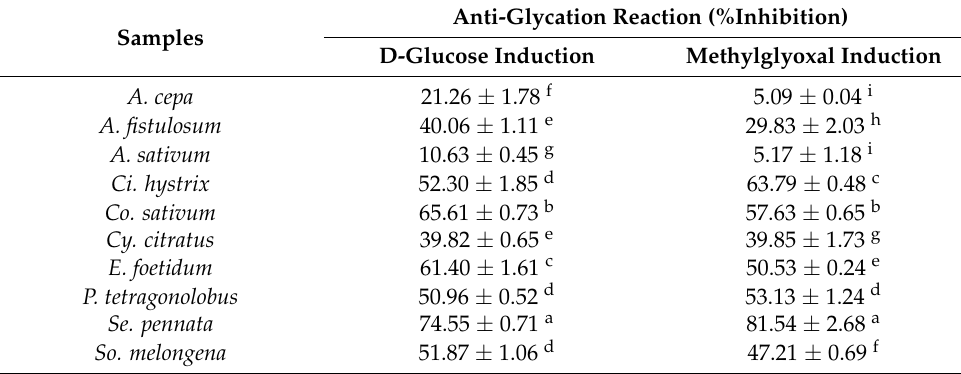
Table 5. Non-enzyme inhibitory activities of the ten vegetable